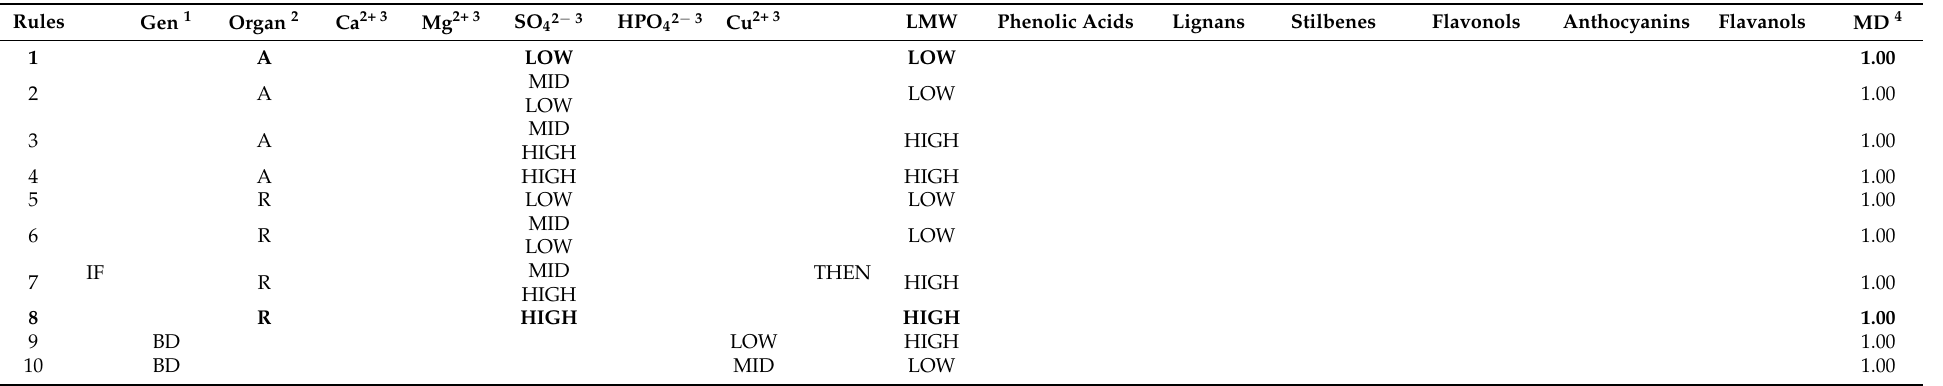
Table 2. ‘IF–THEN’ rules generated by the neurofuzzy model. Bold rules indicate the inputs with the highest membership degree, showing the highest contribution for each output.